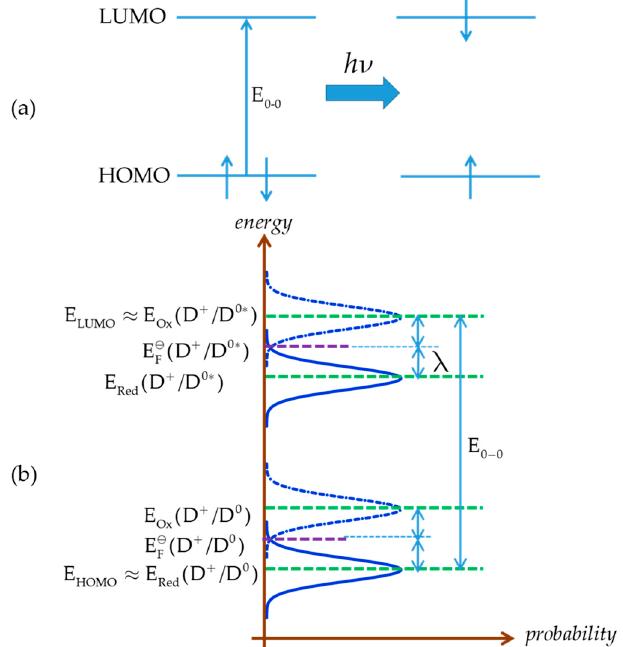
Figure 2. Energy diagram of the ground and excited state of a dye according to the Marcus–Gerischer theory; ( a ) principle electron excitation from higher occupied orbital (HOMO) to lower unoccupied orbital (LUMO); ( b ) energy levels for ground and excited state of dye.